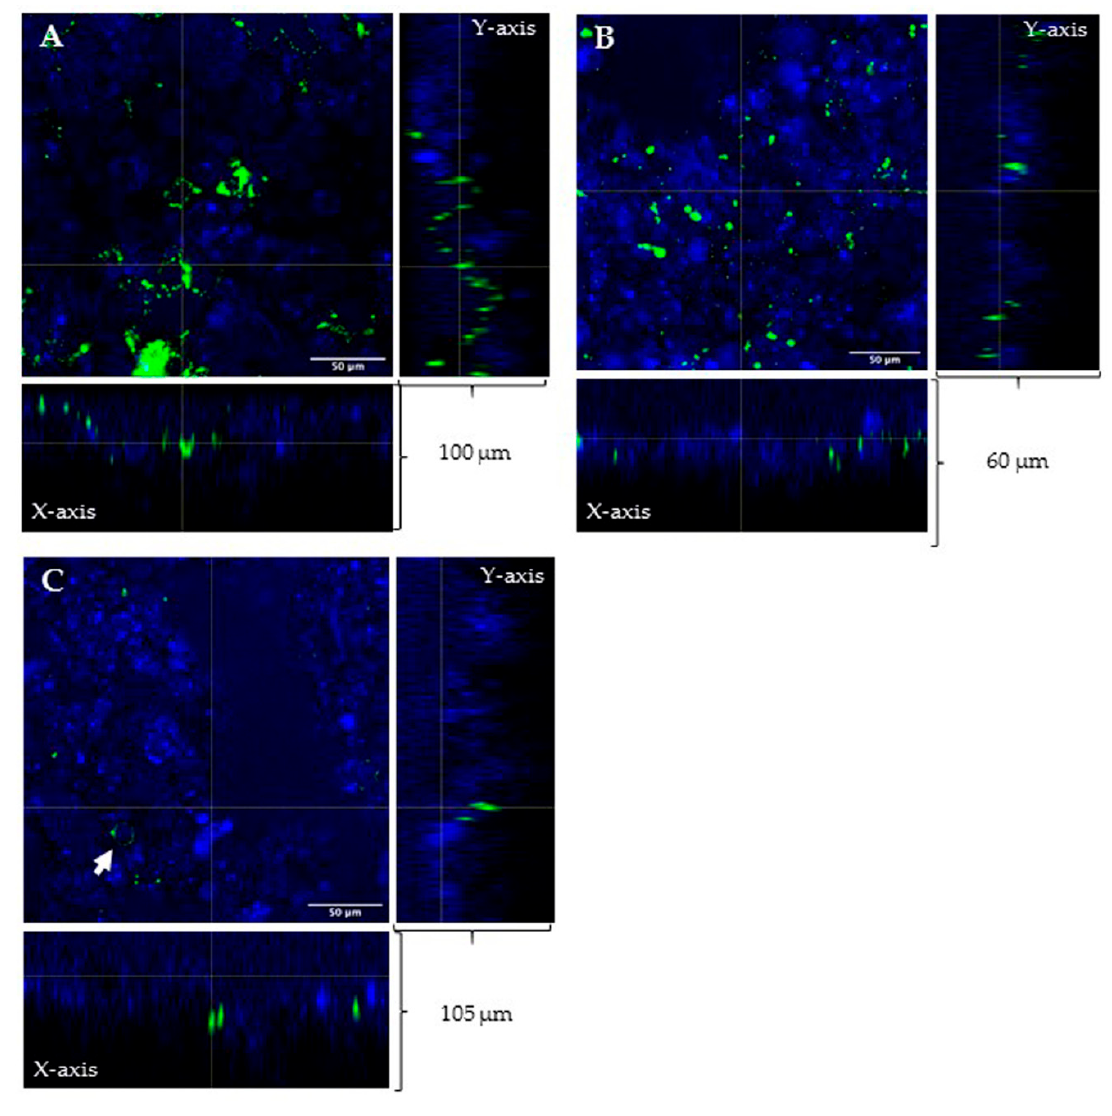
Figure 3. Confocal images of mucus layer di ff usion of LIP ( A ), LIP-HA4800 ( B ), and LIP-HA14800 ( C ). (A–C) Cross-sectional profiles of the z-stack show green signals of liposomes and blue signals of DAPI (nuclei of cells) on both X and Y axis planes. LIP were found in all z-stacks ( A ). LIP-HA4800 ( B ) and LIP-HA14800 ( C ) were able to go deeper in the mucus layer. Arrow indicates interaction with Calu-3. Scale bar = 50 μ m.